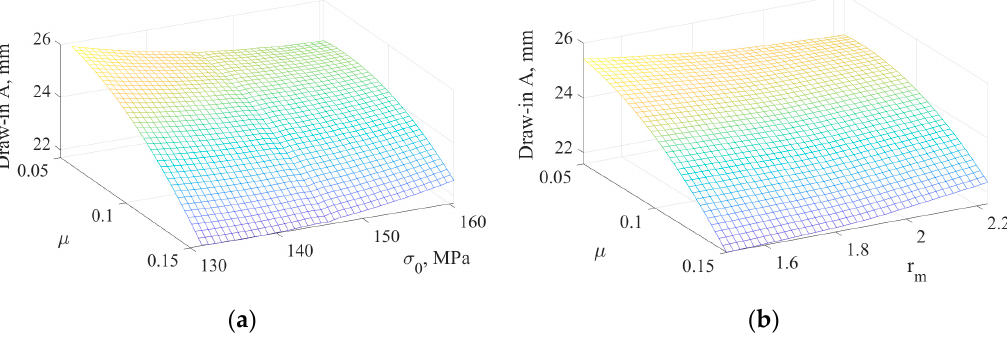
Figure 15. Metamodel of the draw-in at point A for a fluctuation in ( a ) µ and σ 0 and ( b ) µ and r m .